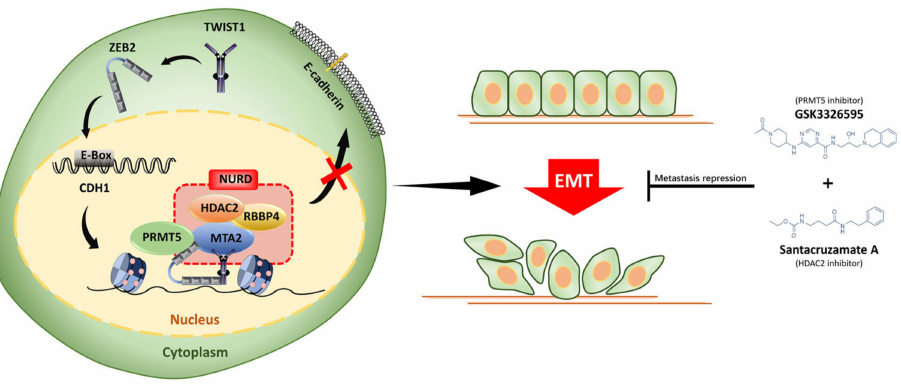
Figure 7. A proposed working model of the role of the ZEB2/TWIST1/PRMT5/NuRD complex in EMT and tumor metastasis in